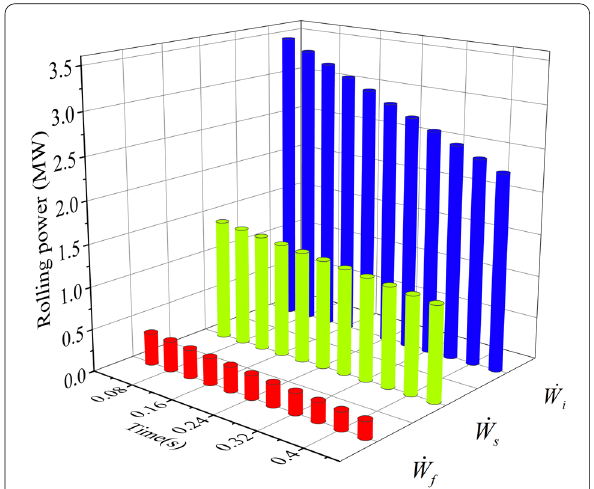
Figure 11 Variation of powers in upward rolling